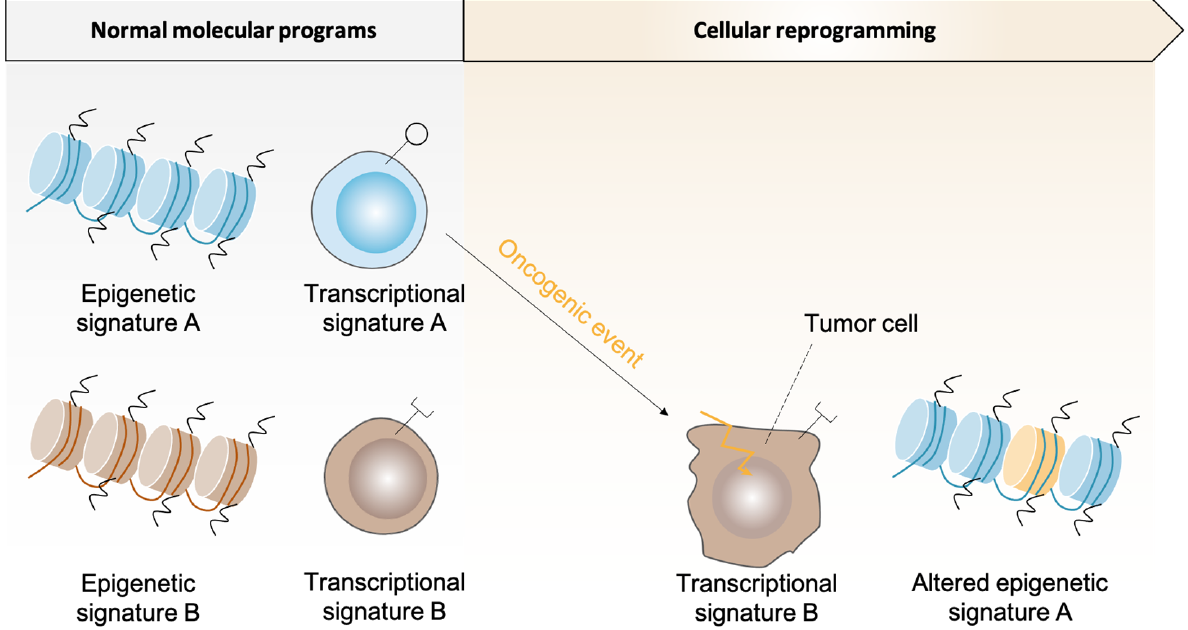
Figure 2. Epigenetic memory as a robust tool to infer cancer cell-of-origin. During tumorigenesis, oncogenic driver events can lead to drastic changes in the transcriptomic landscape of the transformed cell and mechanically modify the histological and morphological properties of the cancer cell compared to its initiating counterpart. Epigenetics comprises robust molecular marks of tissue-specific developmental program that may be retained during cancer initiation and progression.